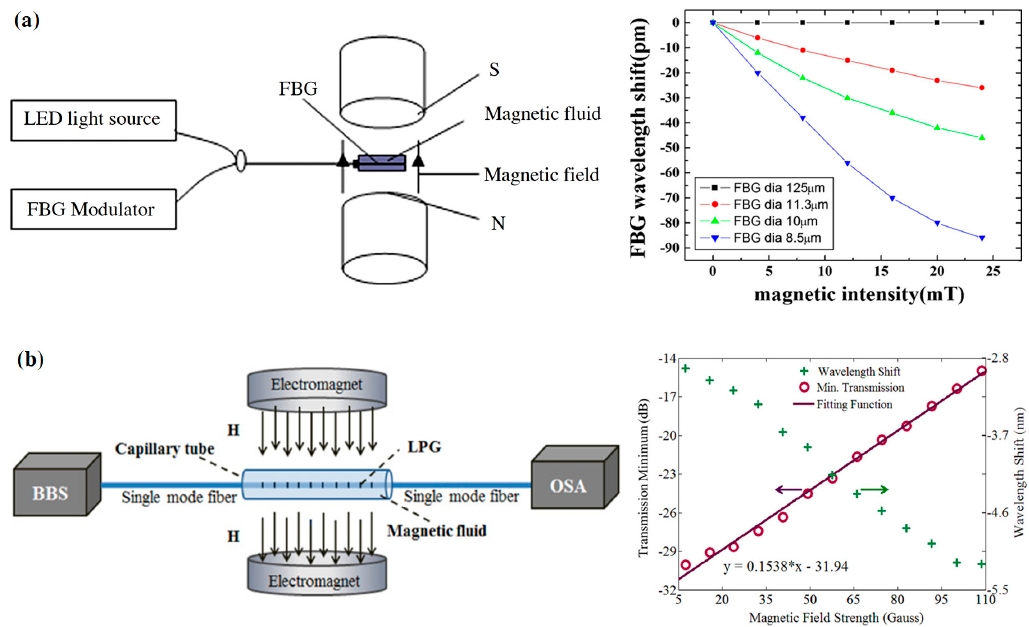
Figure 7. ( a ) Magnetic field sensing system based on etched FBG immersed into magnetic fluid (MF) and the responses of sensors with different FBG diameters to magnetic intensity [51] and ( b ) Sensing system based on Long period fiber grating (LFBG) and the relationship between output power of transmission light and magnetic field strength [52]; permission conveyed through the Copyright Clearance Center, Inc.